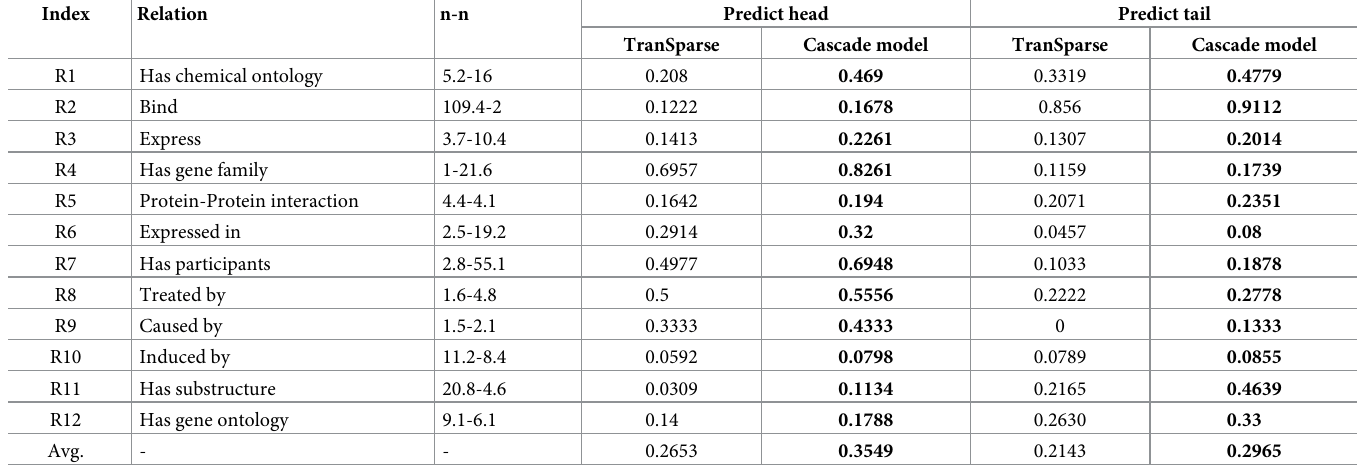
Table 8. Hit@10 rate in each relation on biochemical data set. n stands for the average number of head entities(respectively. tail entities) on dataset given a pair (r, t) (respectively